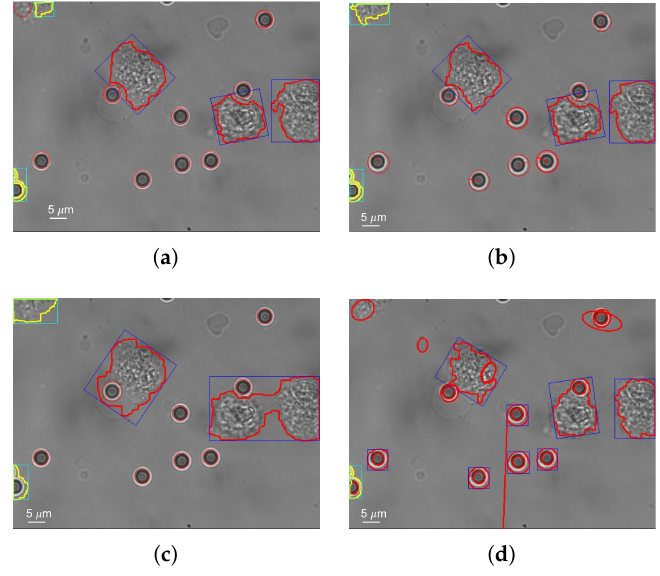
Figure 21. Processed images of human endothelial cells and silica beads in water using various perception methods: ( a ) MSER with circularity parameter; ( b ) SURF; ( c ) Canny edge detector with Otsu’s thresholding; ( d )